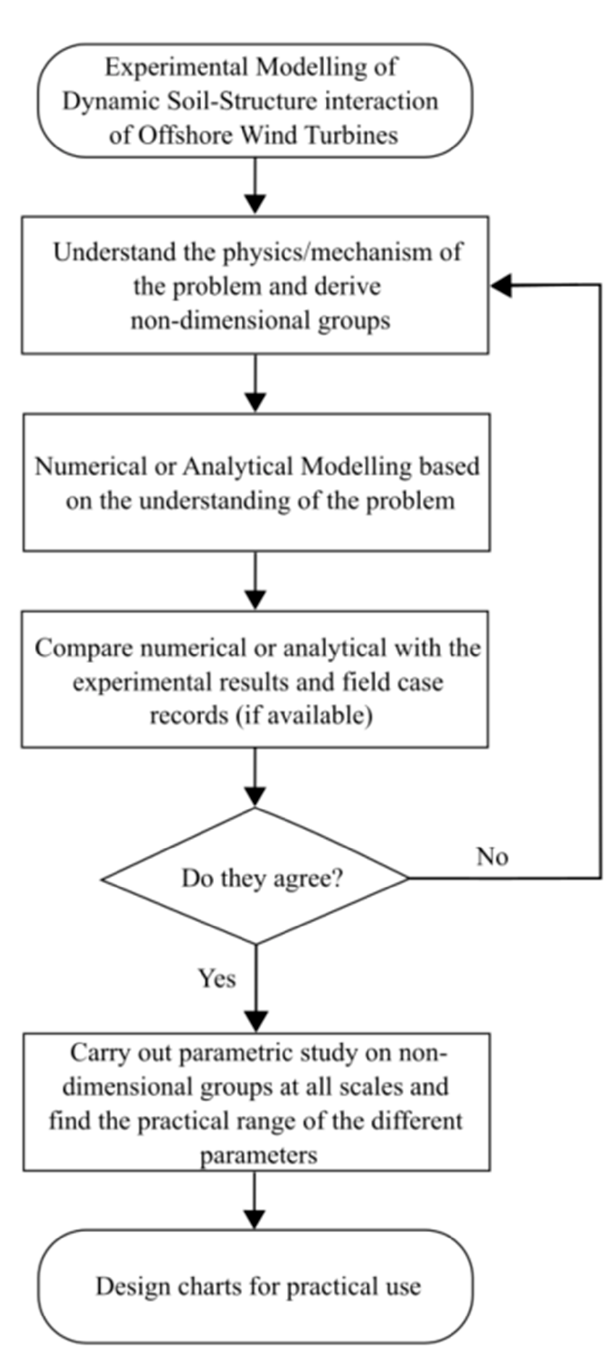
Figure 10. Flowchart showing the usefulness of scaled laboratory testing (Bhattacharya, 2019).